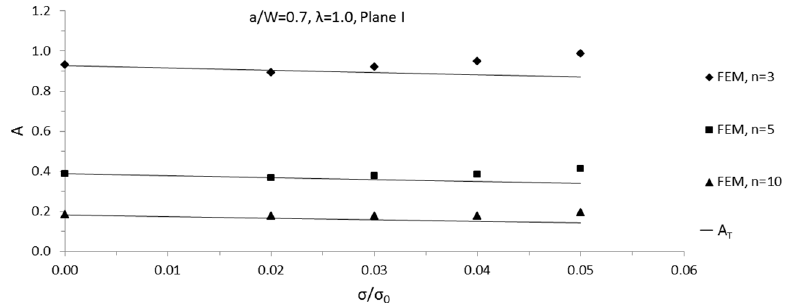
Figure 7. Comparisons of predicted 3D SECP A values with FEA data, biaxial ratio λ = 1.0, a/W = 0.7, in plane I.